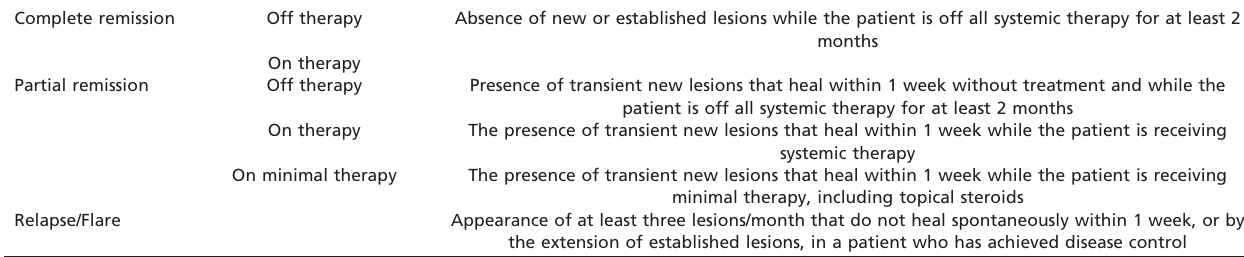
Table 1 - Classification of disease